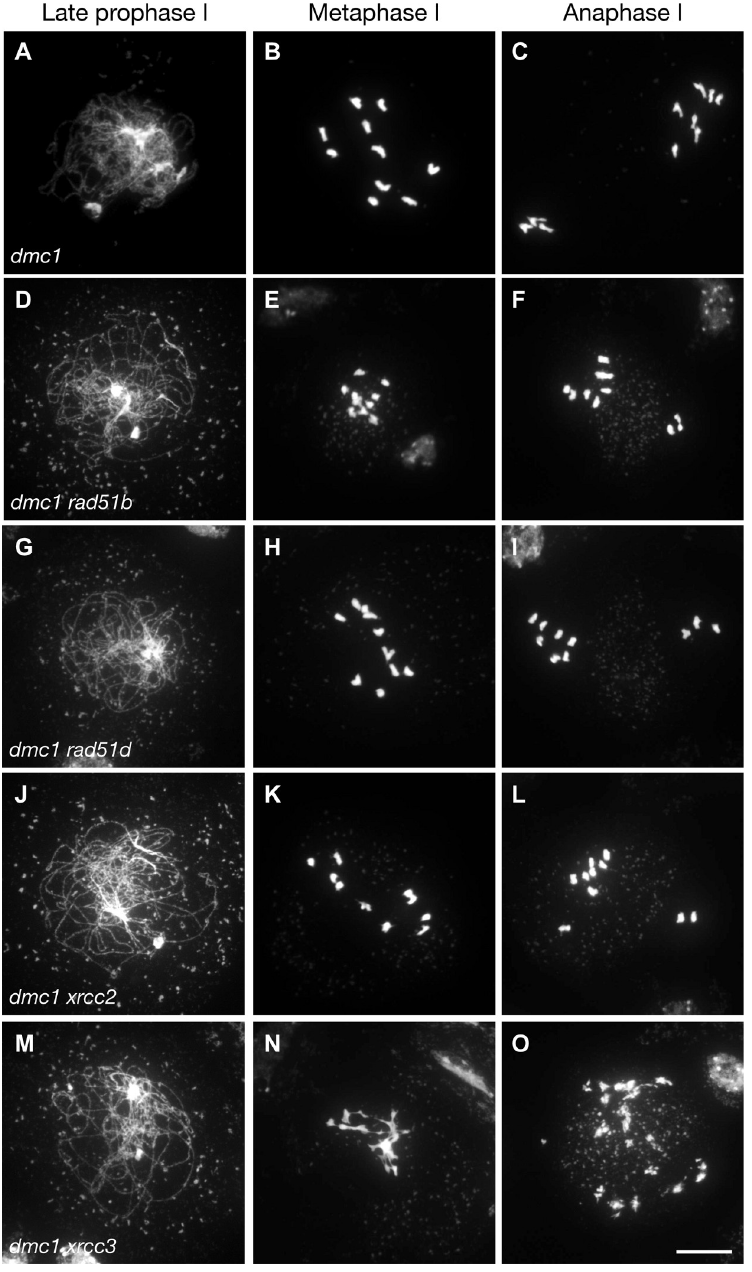
Fig 6. Absence of RAD51B, RAD51D or XRCC2 does not affect dmc1 meiosis. Male meiosis is shown in (A-C) dmc1 , (D-F) dmc1 rad51b , (G-I) dmc1 rad51d , (J-L) dmc1 xrcc 2, and dmc1 xrcc3 (M-O). Chromosome spreads at (A,D, G,J,M) late prophase I, (B,E,H,K,N) Metaphase I, (C,F,I,L,O) Anaphase I. Chromosomes were spread and stained with DAPI. (Scale bar = 10 μ